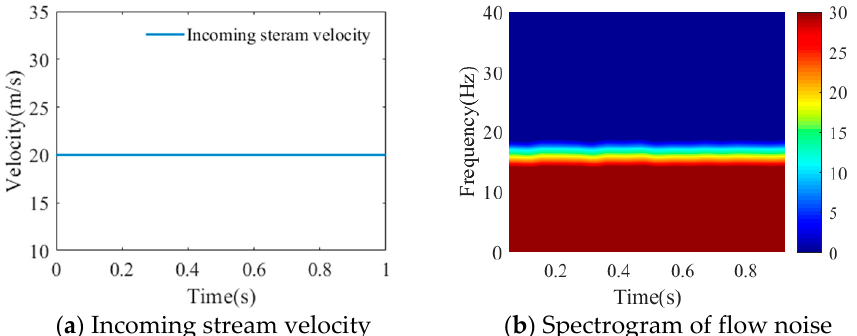
Figure 10. Constant incoming stream velocity and the corresponding spectrogram of flow noise.